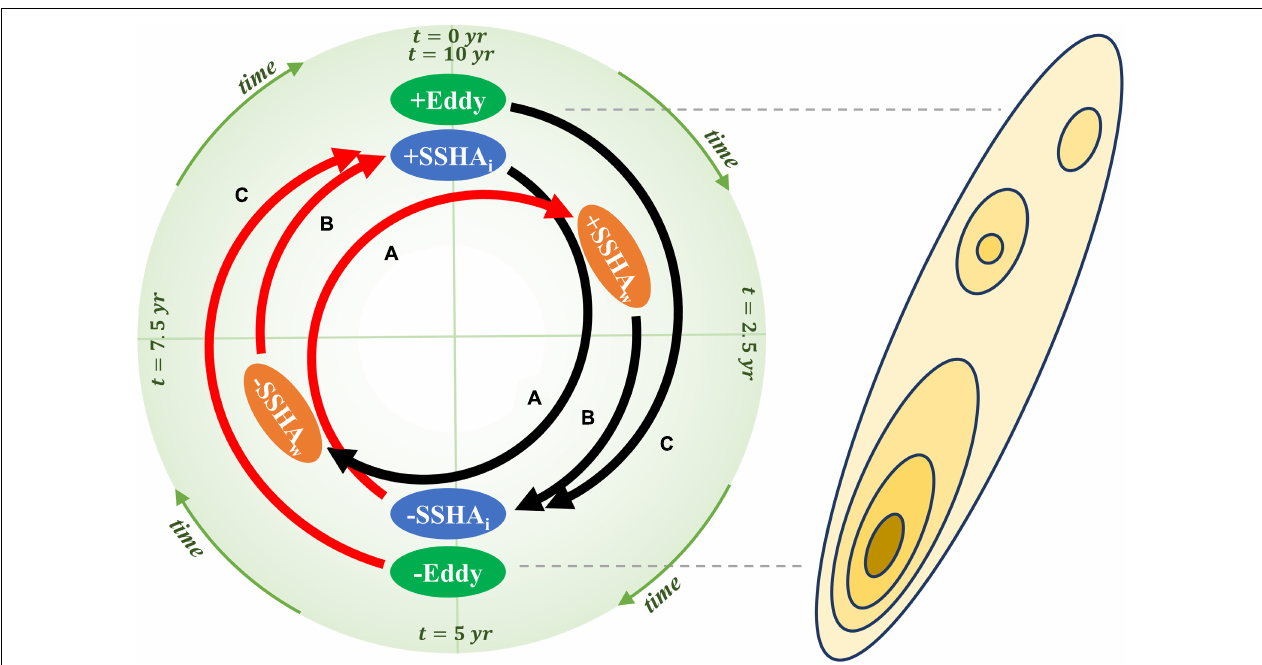
FIGURE 8 | Sketch showing the decadal cycle of the intrinsic SSHA (SSHA i ), mesoscale eddies, and wind-driven SSHA (SSHA w ) with a diagram of the Shatsky Rise. Time evolves in the clockwise direction, and the thick arrows denote the (A) delayed modulation of wind-driven SSHA by intrinsic KE variability (B) delayed negative effect of wind-driven SSHA on the KE’s strength; (C) delayed energy feedback from eddies to the KE jet. The black and red colors indicate different polarities of the above feedbacks.